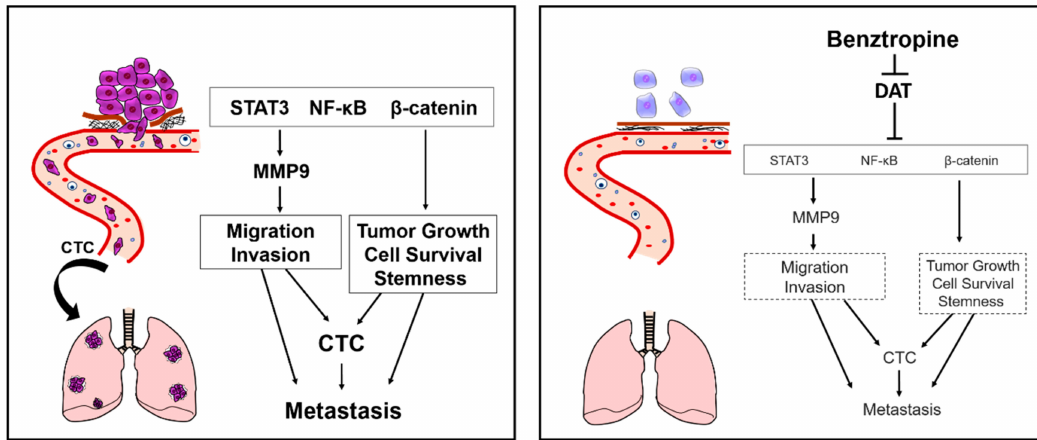
Figure 8. Graphical abstract . Tumor growth, enhanced migration, invasion, and stemness are essential for the properties of aggressive, refractory cancers. STAT3, NF- κ B, and β -catenin are oncogenic signaling trans-activators crucial for these properties and for activation of the MMP9 gene. These phenotypes often enable tumor cells to disseminate to the bloodstream as CTCs and to distant organs for establishing metastasis. Benztropine suppresses the properties of aggressive, refractory cancers by acting on the dopamine transporter SLC6A3 and reducing the pro-tumorigenic factors including STAT3, NF- κ B, and β